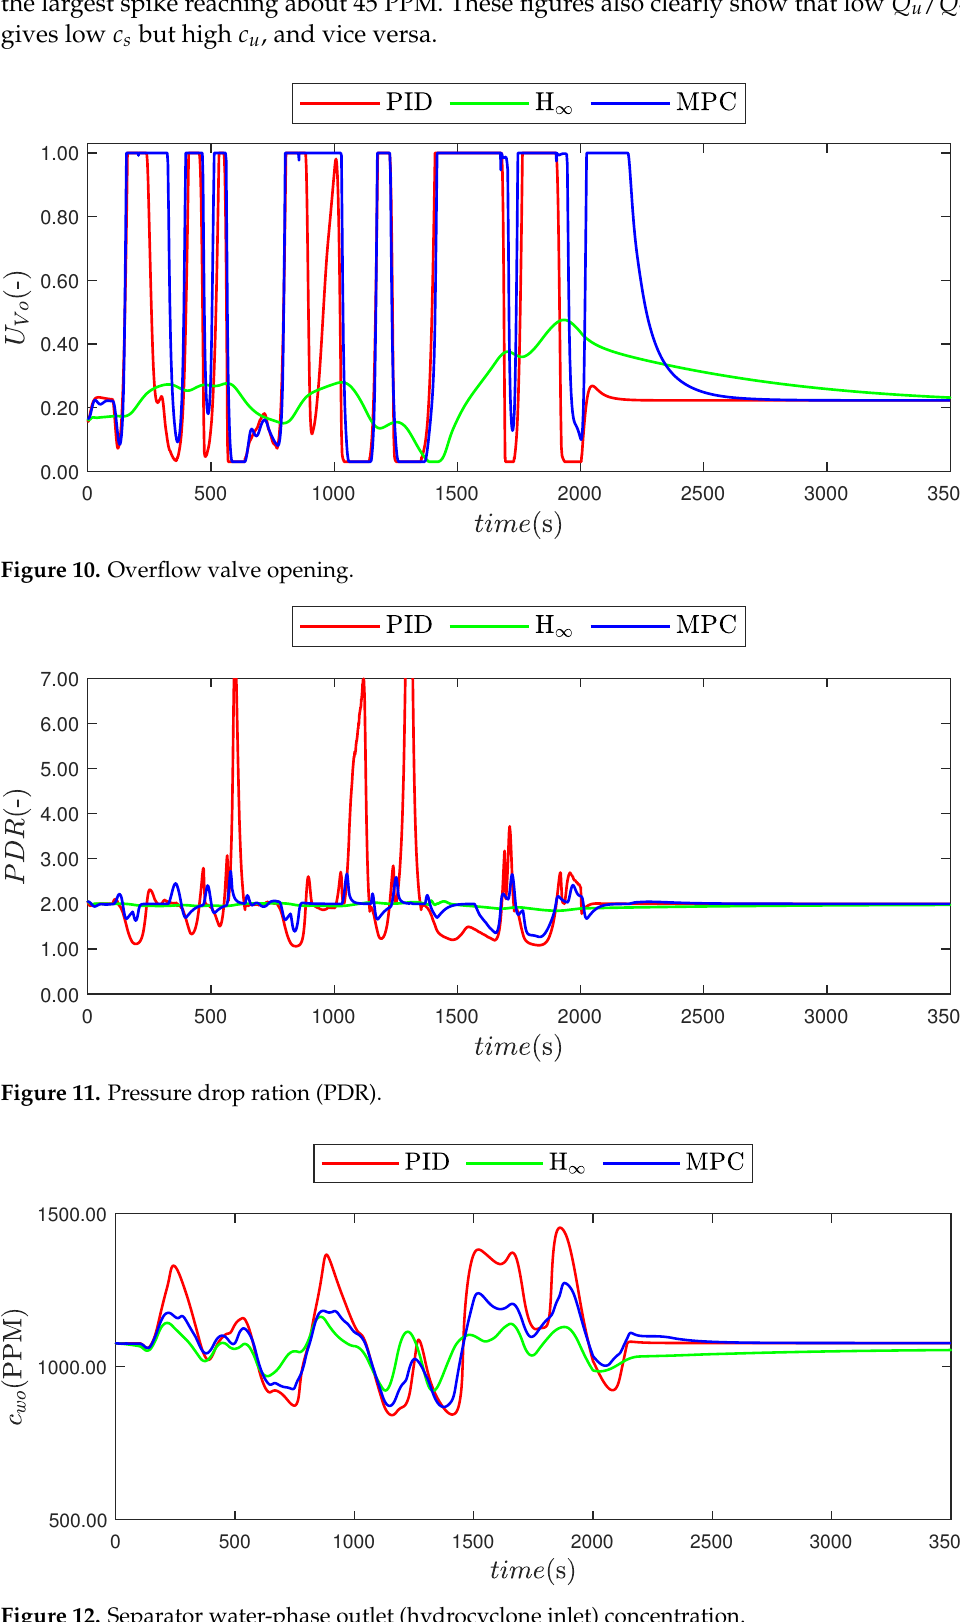
Figure 12. Separator water-phase outlet (hydrocyclone inlet)